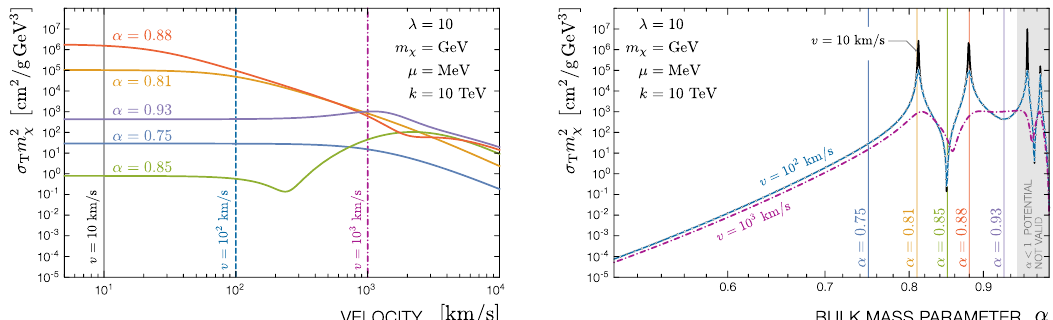
Figure 6 . Transfer cross section as a function of relative dark matter velocity v (left) and bulk mass parameter α (right). The plots demonstrate the presence of resonances and anti-resonances. Vertical markers identify parameters used in the opposite